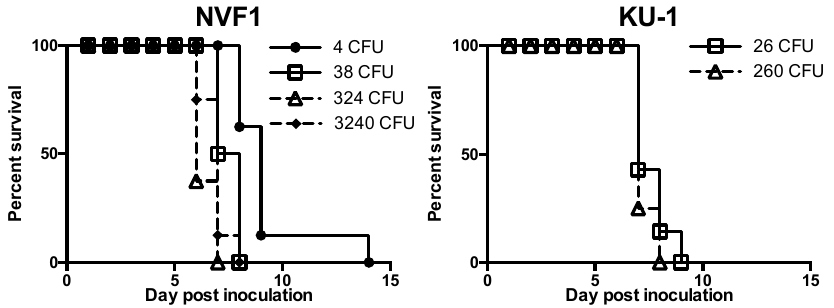
Figure 1. Survival of mice inoculated with Francisella tularensis NVF1 and KU-1. C57BL / 6J mice ( n = 7 or 8 / group) were challenged with indicated colony-forming units (CFUs) of NVF1 and KU-1 strains intradermally and their survival was monitored over time. The data for NVF1-inoculated mice represent the combined data of two separate experiments.